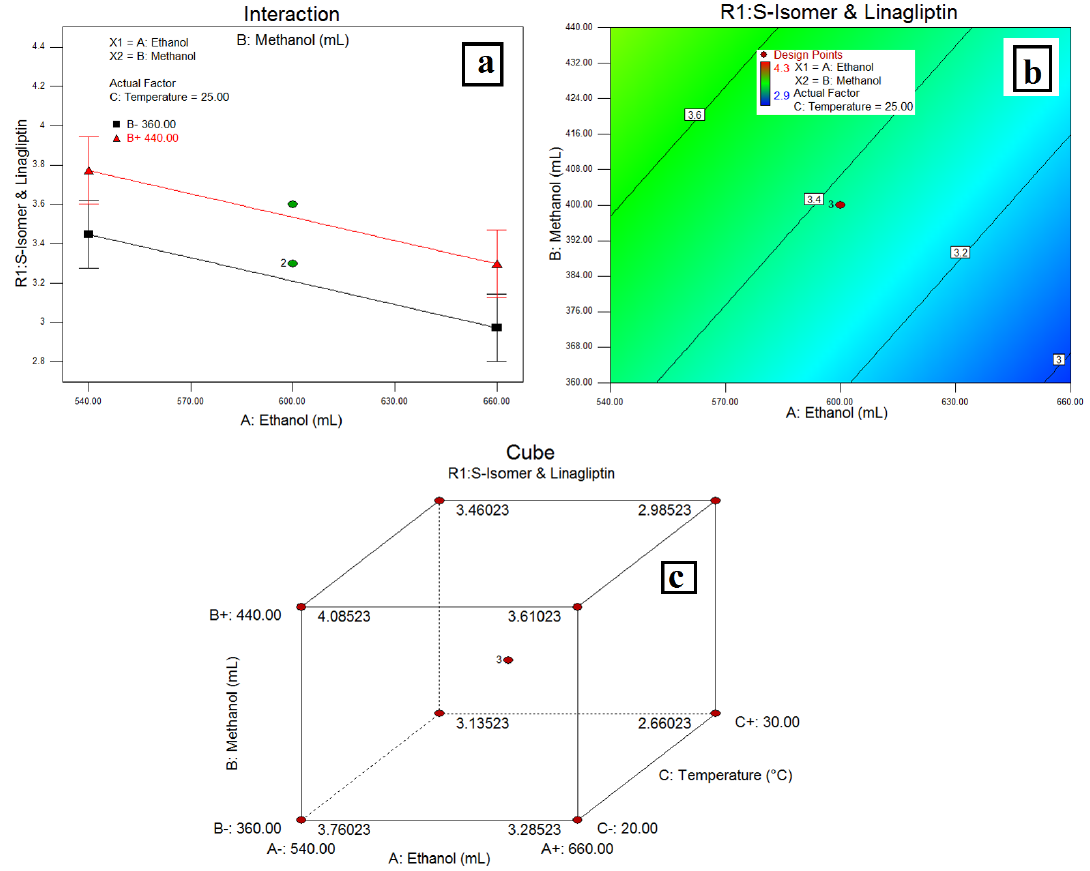
Figure 3. Interaction of MeOH and EtOH on resolution of the S -isomer and LGP ( a ); Desirability plot ( b ) and cube ( c ) showing the interaction of EtOH, MeOH and temperature.